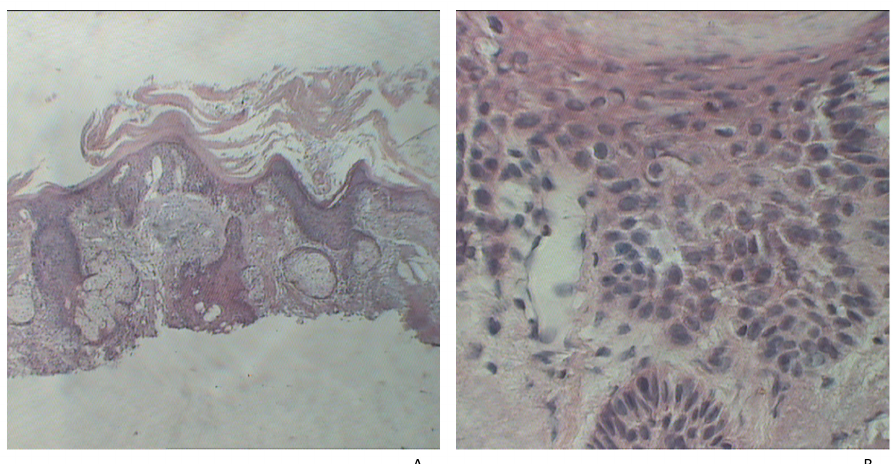
Figure 2. Histopathological examination of AK. ( A ) Disorganized growth, which disrupts differentiation (HE, ×10). ( B ) Dysplasia of basal keratinocytes (HE, ×90).